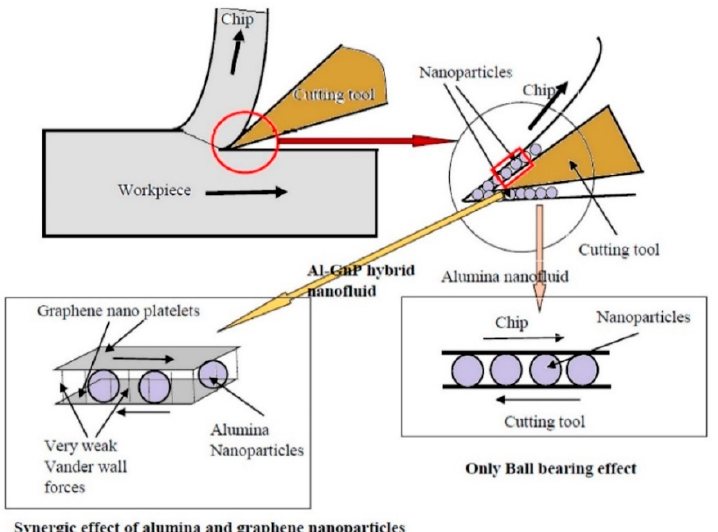
Figure 2. Synergic influence of the Al 2 O 3 and Al 2 O 3 –graphene nanoplatelets trapped between the sliding surfaces. Reprinted with permission from Ref. [79]. 2018